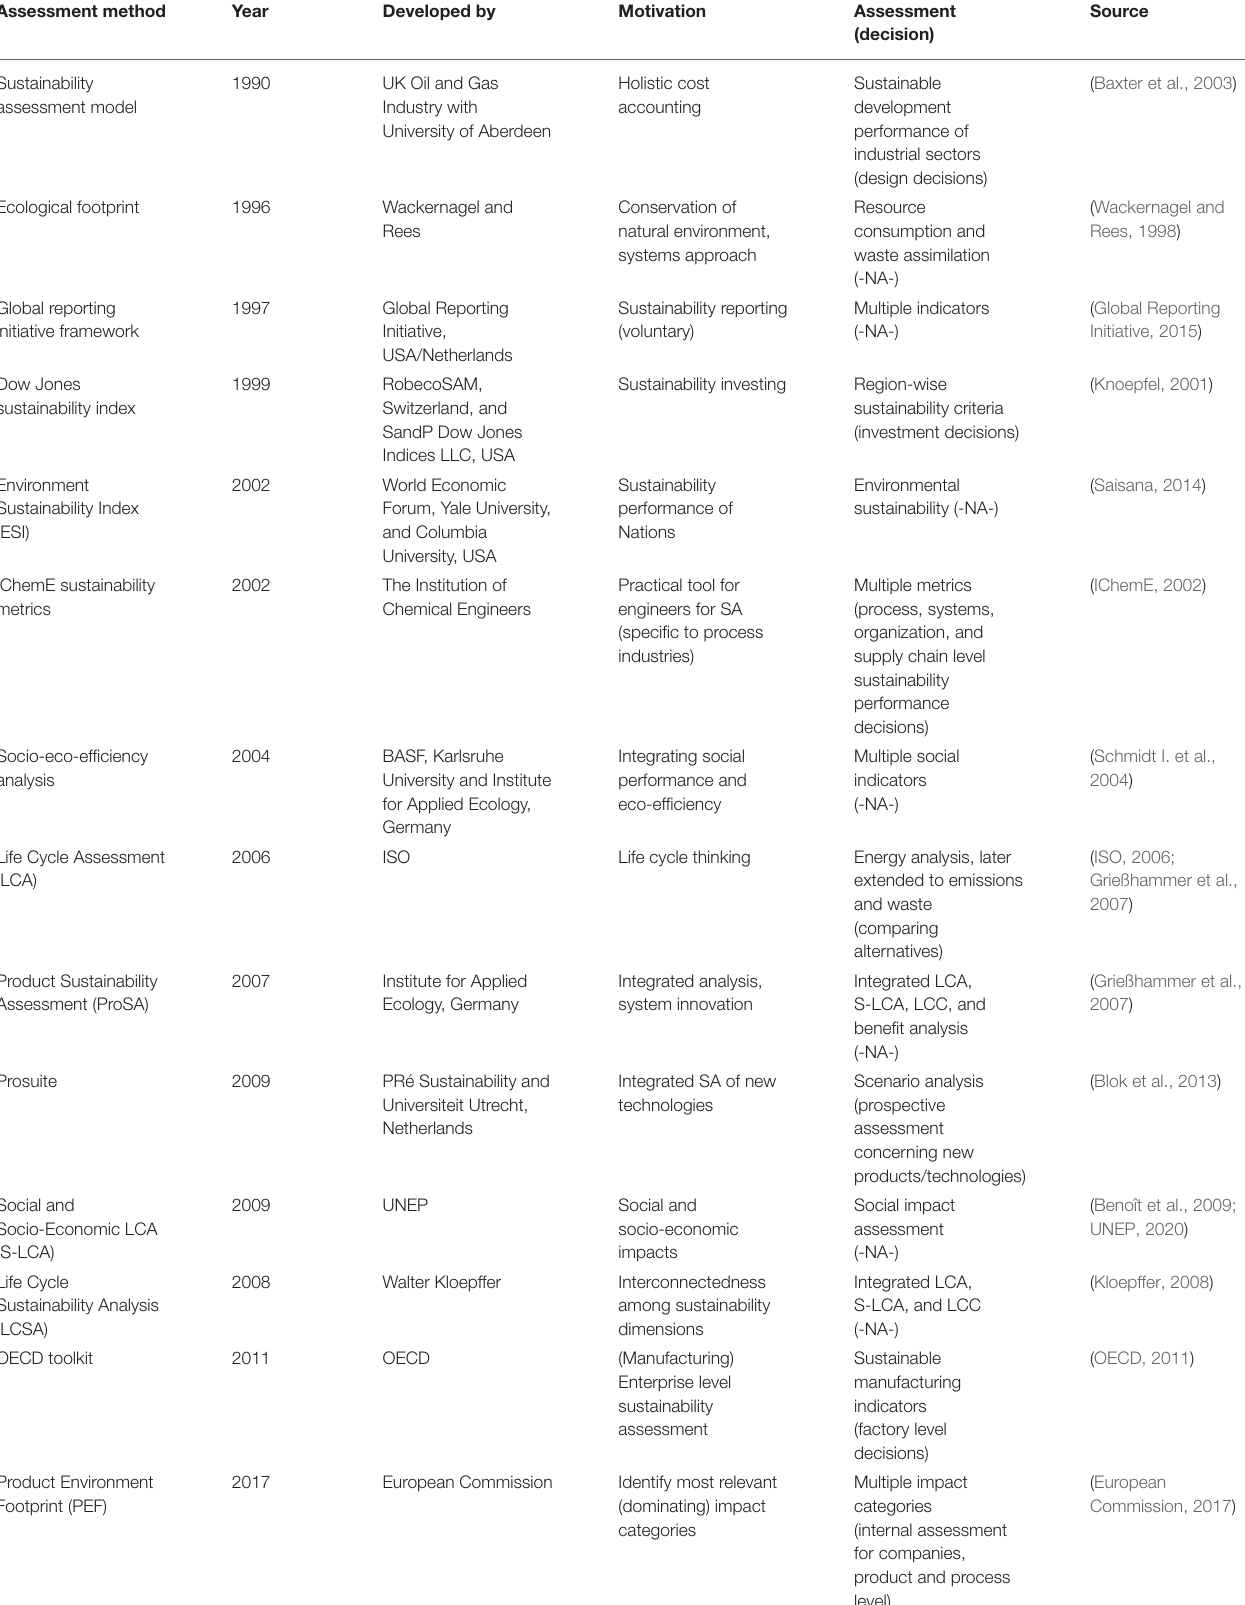
TABLE 2 | Product sustainability assessment methods (chronological